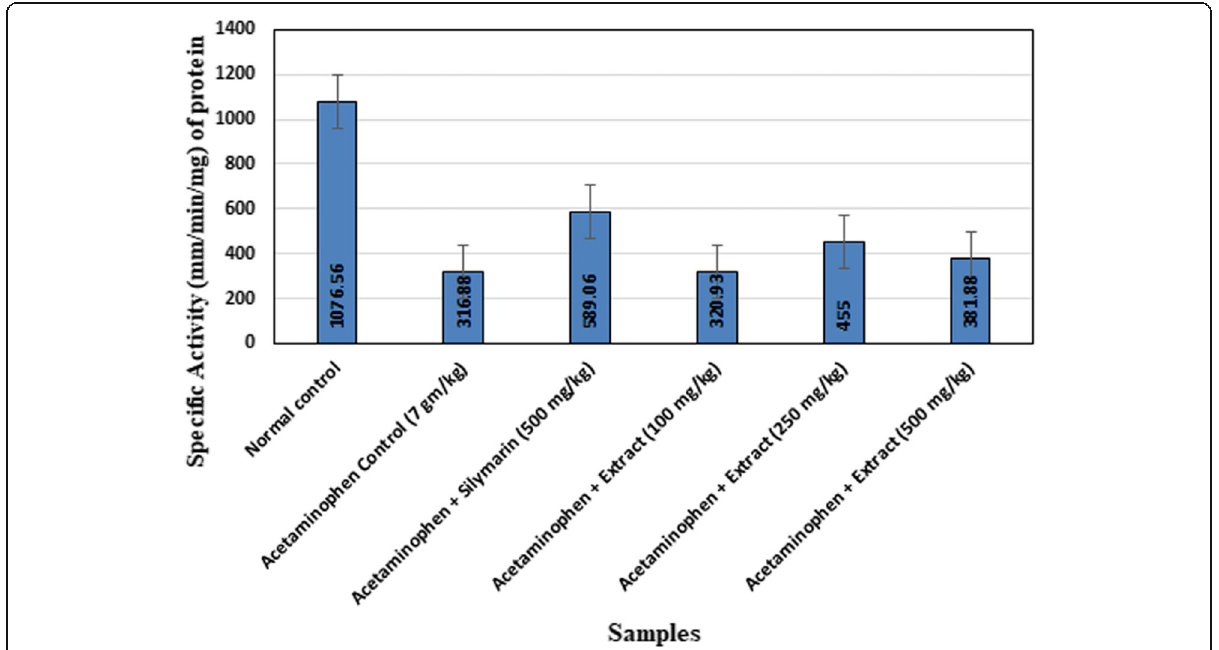
Fig. 2 The antioxidant enzyme (catalase) level in Acetaminophen-induced liver damage